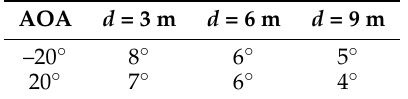
Figure 20. CDFs of errors of AOA estimation under different height of the target. Table 1. The median AOA estimation errors with different d .